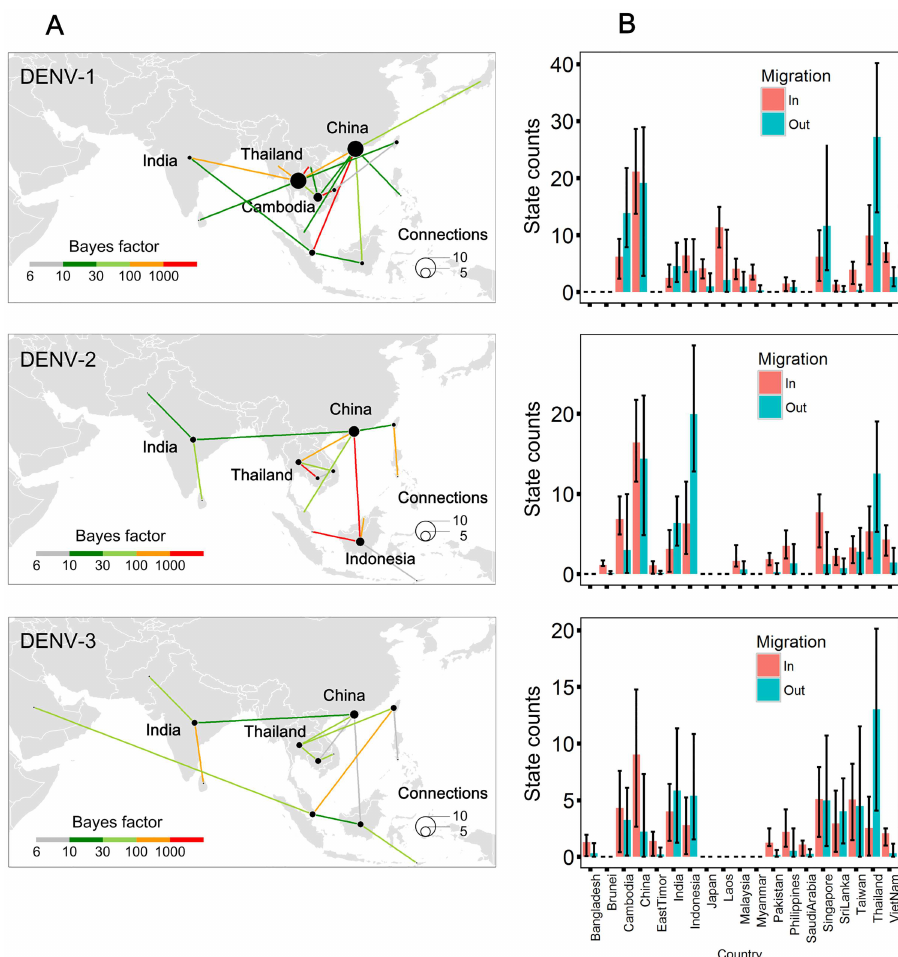
Fig 5. Strongly supported pathways of lineage movement and histograms of the total number of location state transitions of DENV-1–3in Asia for 1956 to 2015. (A) Strongly supported state transitions, indicating migrationof DENV-1–3lineagesamong discrete locations.The size of points correspondsto the numberof geographicconnections. The colored lines represent statistical support for a given viral movement pathway. Only those viral lineagemovements supported with a BF > 6 are shown. (B) Number of expected transitions into and out of each country per serotype. Error bars represent 95% BCIs.